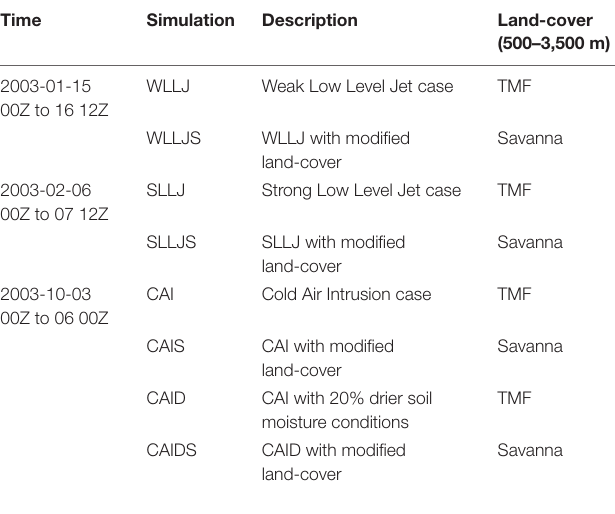
TABLE 1 | Summary of WRF 4.1